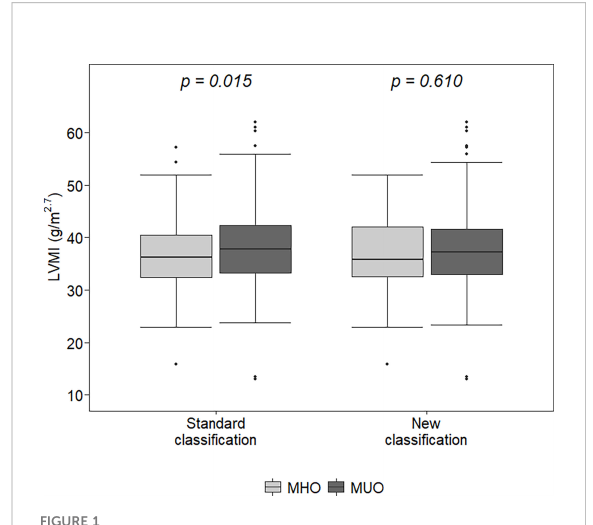
FIGURE 1 Left ventricular mass index (LVMI) in metabolically healthy obese (MHO) and metabolically unhealthy obese (MUO) according to the two classi fi cations. The lower (and upper) whiskers extend up to the lowest (highest) datum still within 1.5 times IQR of the fi rst (third)